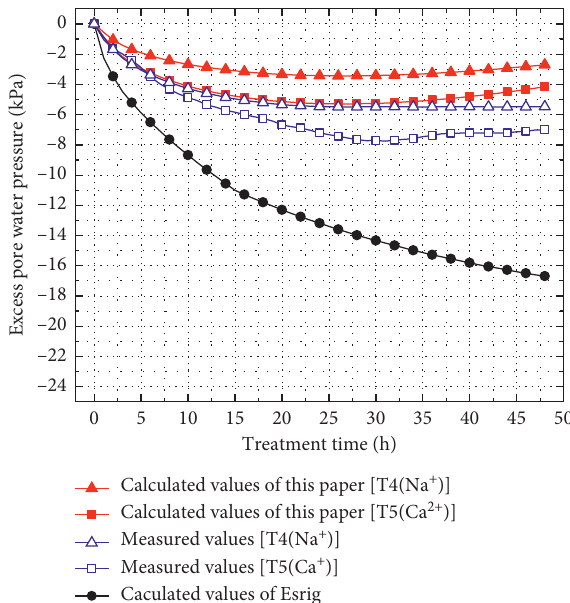
Figure 12: Comparison between the calculated and measured values of excess pore water